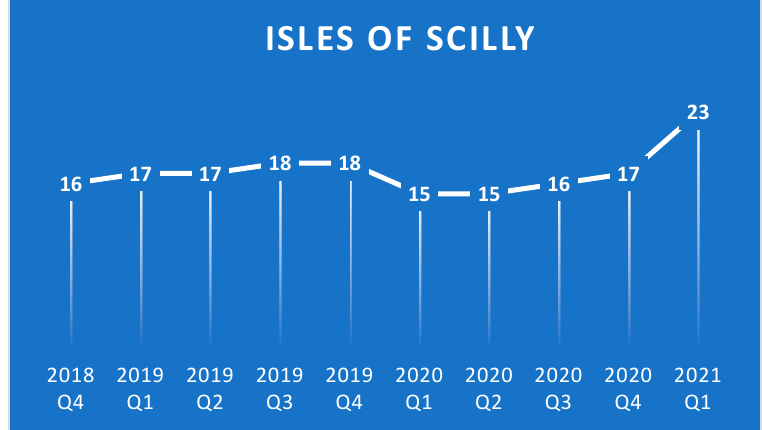
Figure 10. The trend of Ev in the Isles of